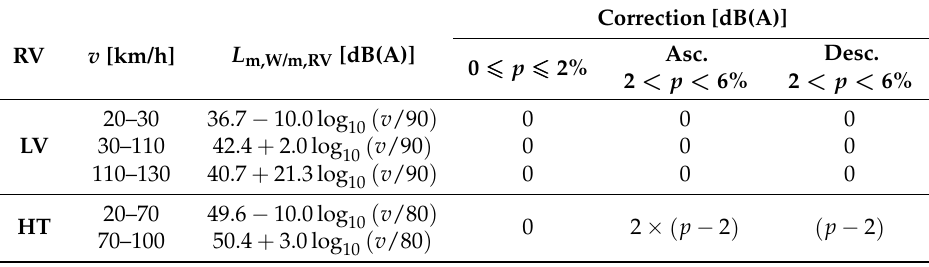
Table 3. Mechanical noise components of the emission powers per metre of lane for LV and HT at steady speed according to v with their respective corrections according to the declivity p (in %, with Ascent (Asc.) and Descent (Desc) declivities) of the road segment (the methodological guide considers accelerating and decelerating road sections too [62] (Tables 2.8, 2.9 and 2.11)). Correction